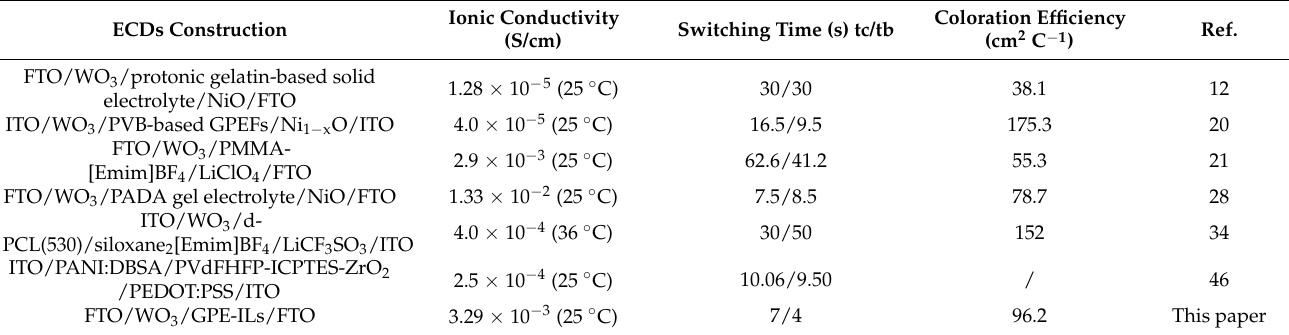
Table 1. Switching times of several reported ECDs and the ionic conductivity of gel polymer